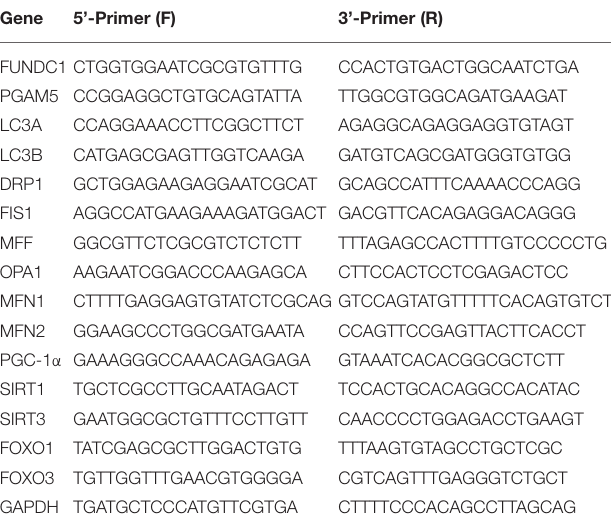
TABLE 1 | Premier sequences used for real-time